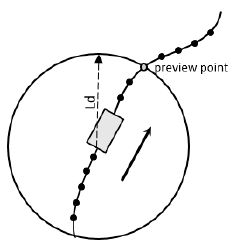
Figure 3. Selection of preview point.